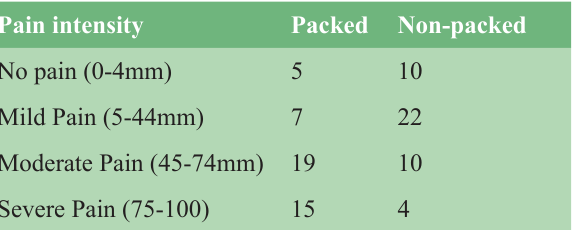
Table 3: Pain assessment using VAS 1-100mm